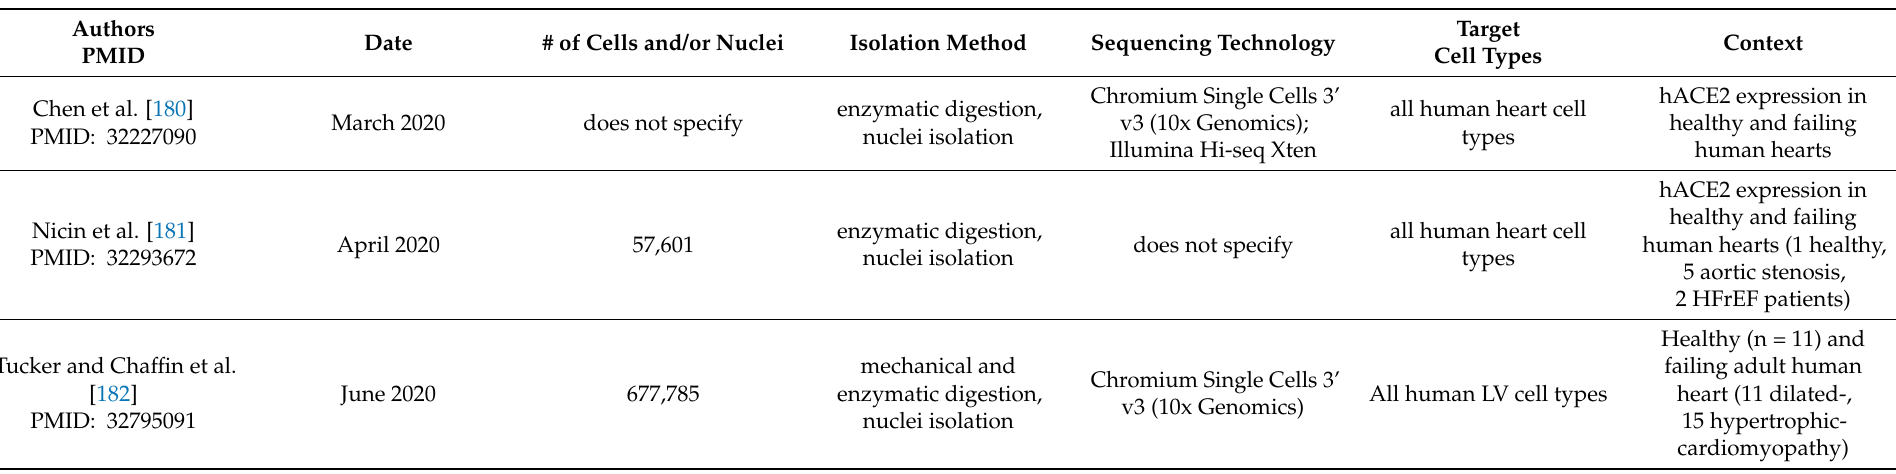
Table 7. Cardiac Single-cell and